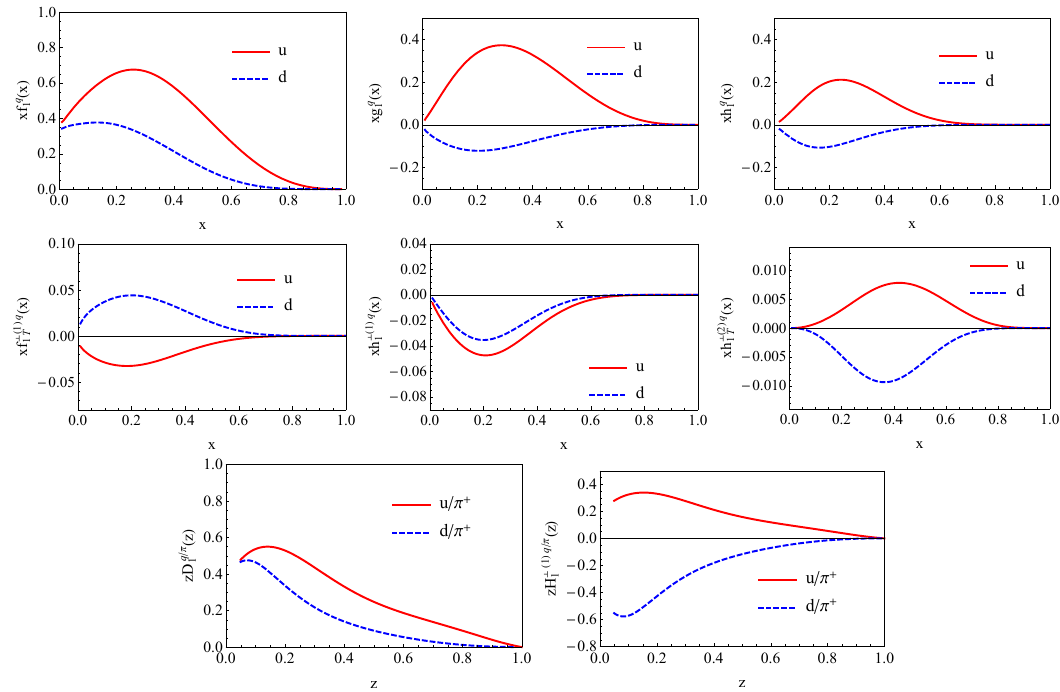
Figure 3. The basis functions f a the basis functions and the Gaussian model parameters are described in detail in appendix